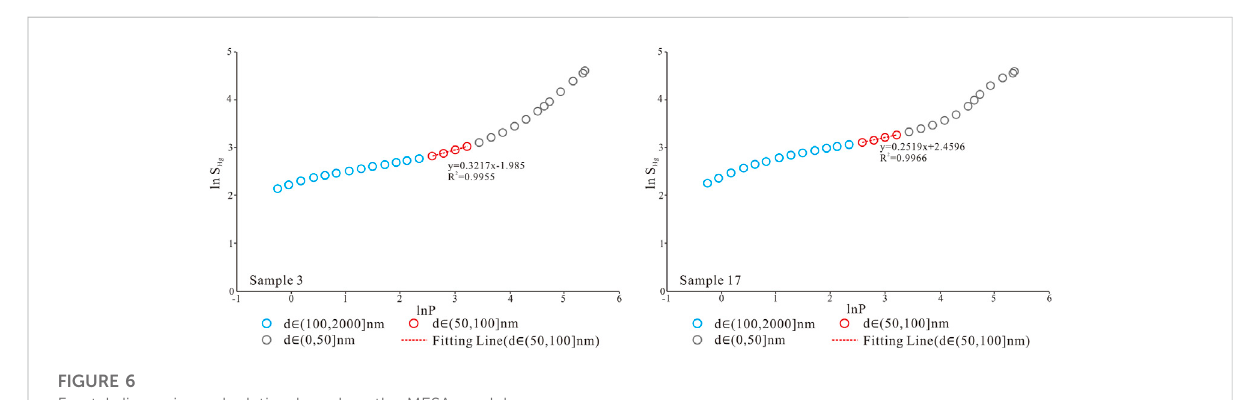
FIGURE 6 Fractal dimension calculation based on the MESA